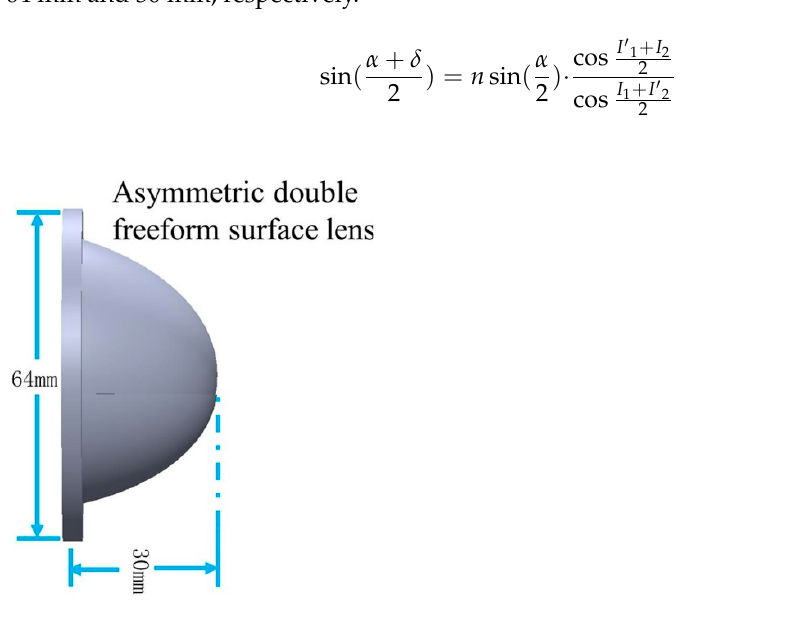
Figure 11. The asymmetric double freeform surface lens.